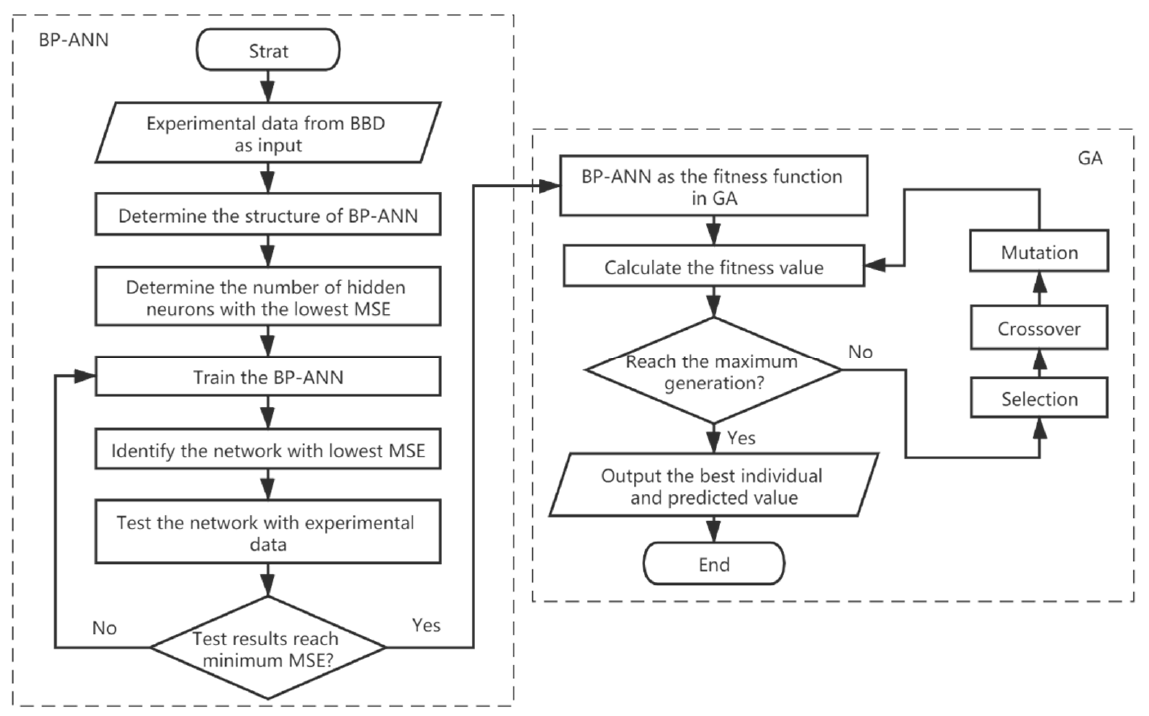
Figure 2. Flow chart of back-propagation artificial neural network (BP-ANN) coupled with genetic algorithms (GA).